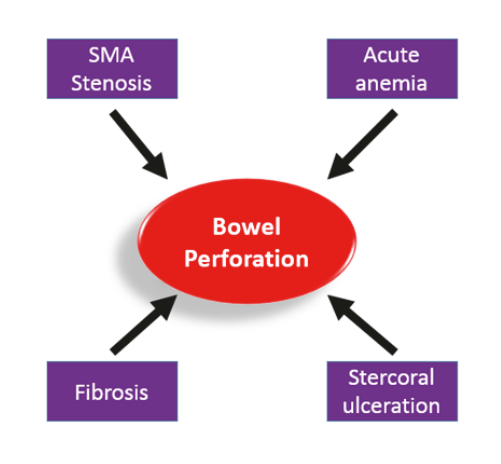
Figure 4: Scheme of the factors contributing to the bowel perfora- tion in this